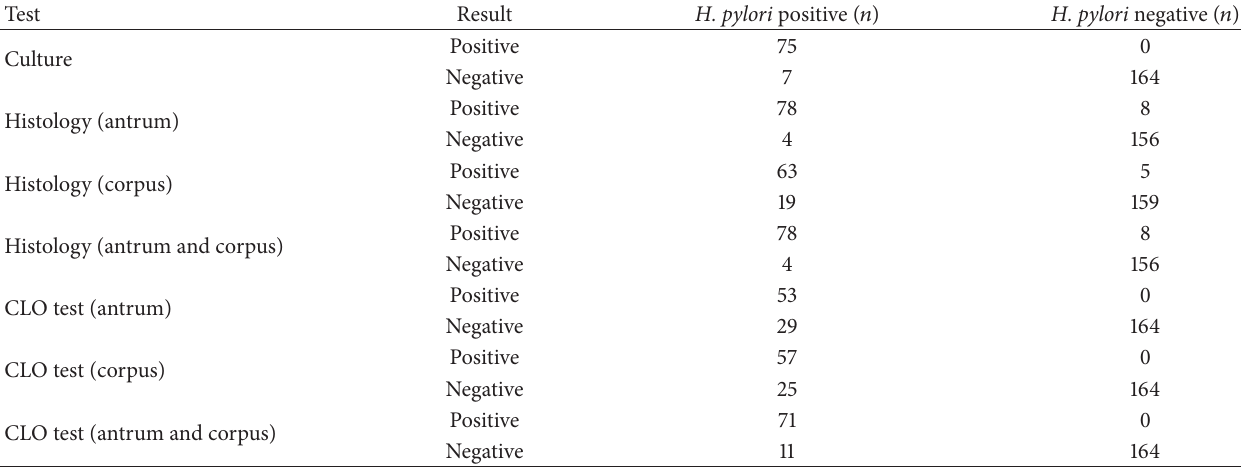
Table 3: Results of the detection of H. pylori by each test according to the “gold standard” definition.